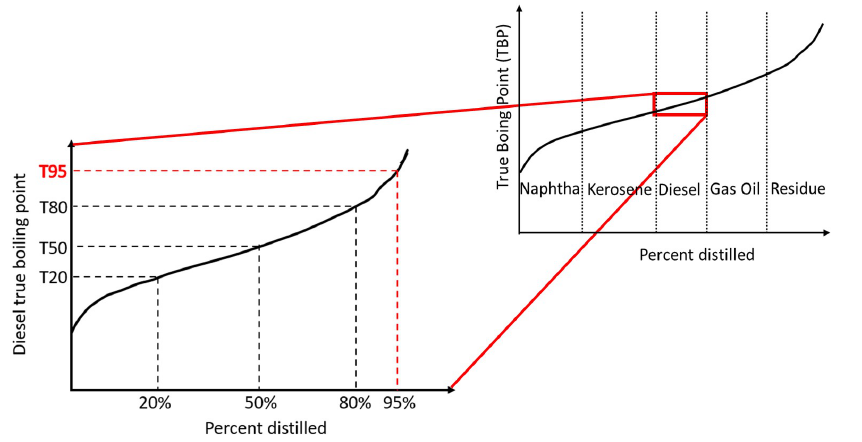
Figure 1. A representative true boiling point curve with T20, T50, T80, and T95 marks, and the location of diesel in crude oil